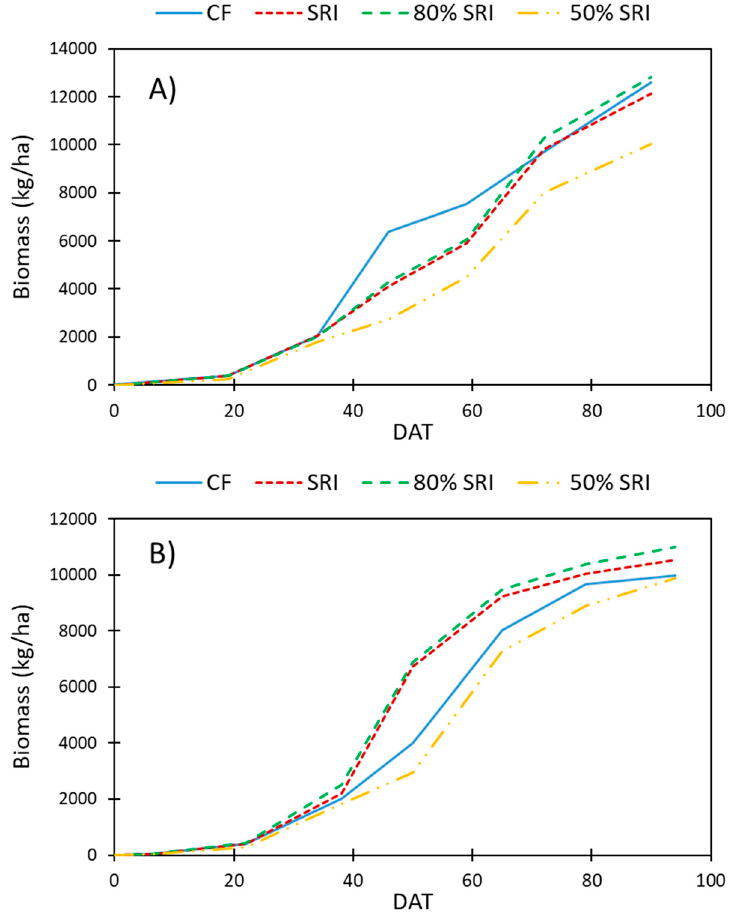
Figure 2. ( A ) Dry season (October 2012 to January 2013) and ( B ) wet season (February 2013 to June 2013) total biomass for continuous flooding (CF), system of rice intensification (SRI), 80% SRI, and 50% SRI treatments. The 80% SRI and 50% SRI refers to 80% and 50% of the SRI ponding depth, respectively. 0 to 46, 47 to 60, 61 to 75, and 77 to 94 days after transplanting (DAT) corresponds to vegetative, flowering, panicle initiation, and senescence stages, respectively.